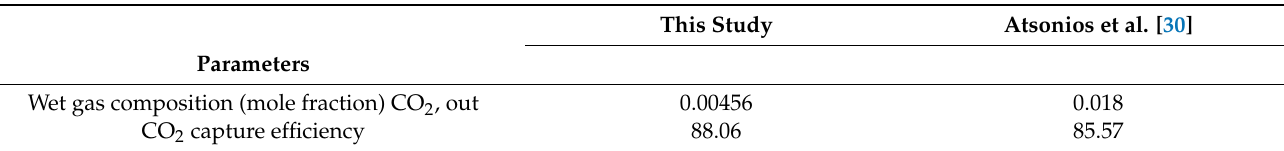
Table 3. Comparison of the CO 2 mole fraction exited from the carbonator reactor and CO 2 capture efficiency from the model prediction and experimental data of Atsonios et al.